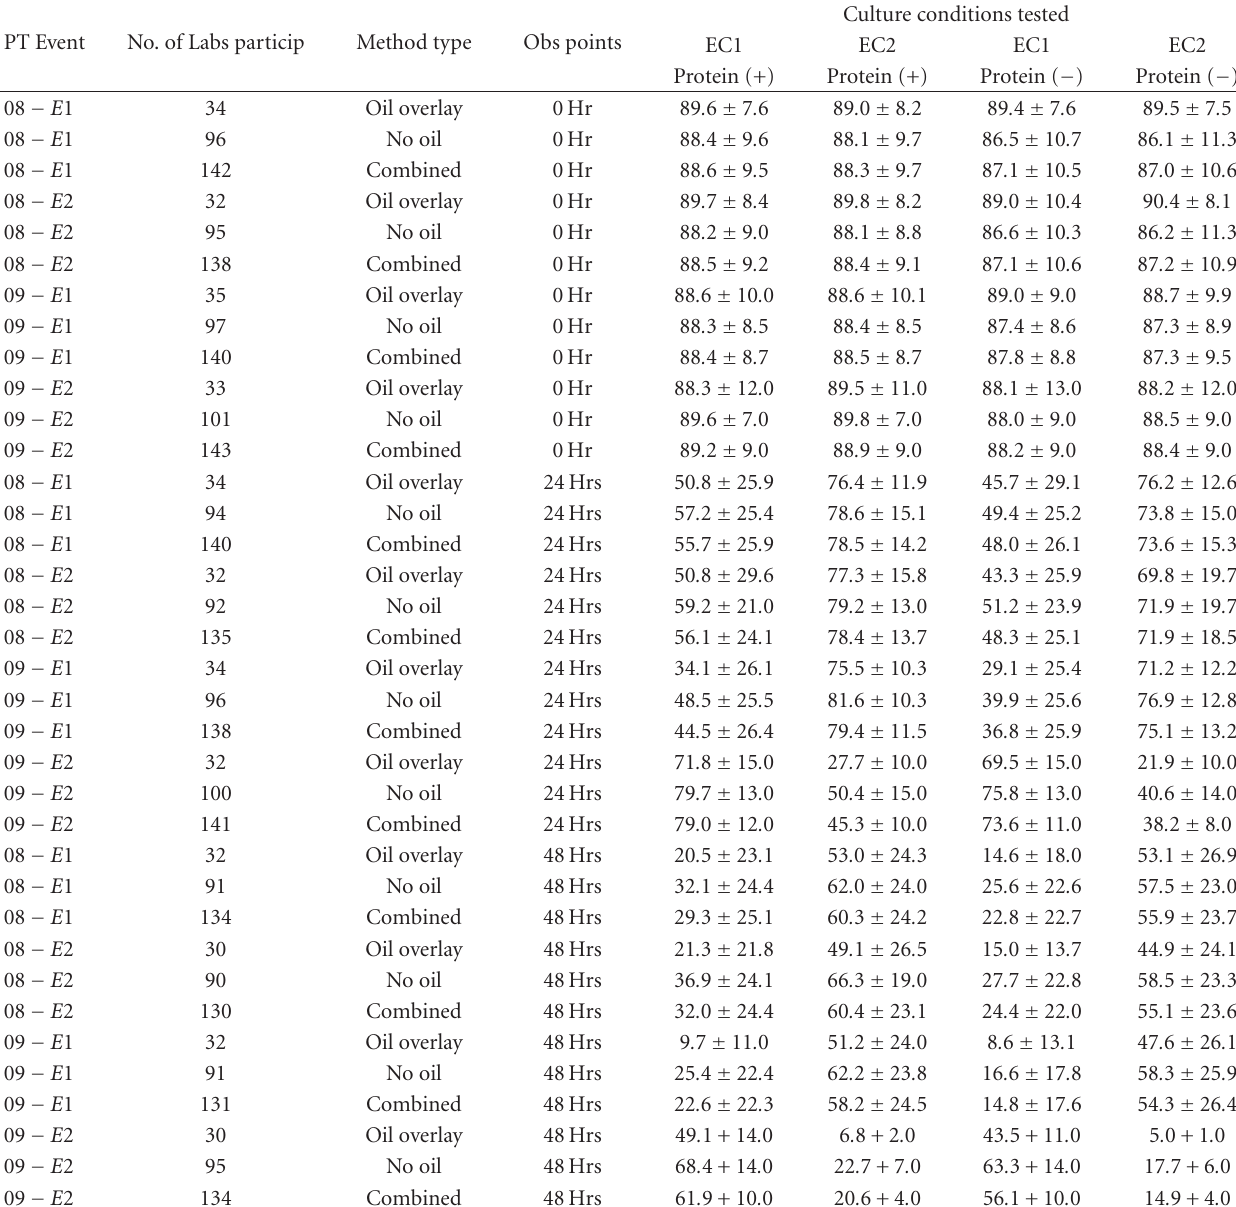
Table 1: AAB-compiled PT data on HSA from the reporting of the participating laboratories for the years 2008 and 2009. The value represents motility (mean ± SD) in respective culture conditions at specified observation